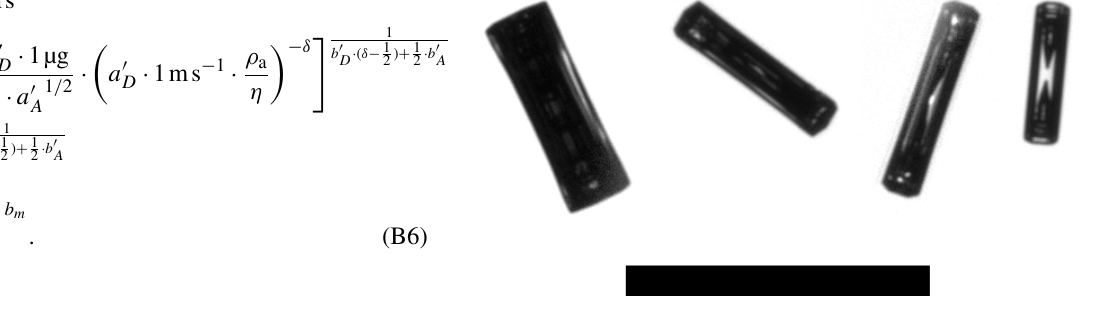
Figure C1. Examples of simple thick columns selected from shape group (3) Thick columns . The black rectangle shown as size refer- ence corresponds to 1mm × 100µm.